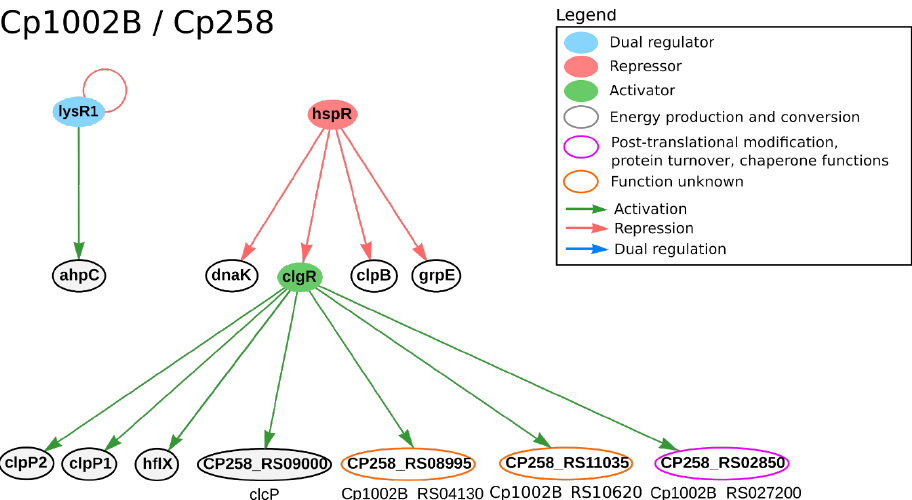
Figure 4. Regulatory interactions from CoryneRegNet 7 for the DEGs of C. pseudotuberculosis 258 (Cp1002B) and 1002B (Cp258) under osmotic, acid and heat stress conditions [41,42]. In the network, nodes represent the genes and arrows represent the regulatory interactions. The functional classification was performed using the database Eggnog [90].